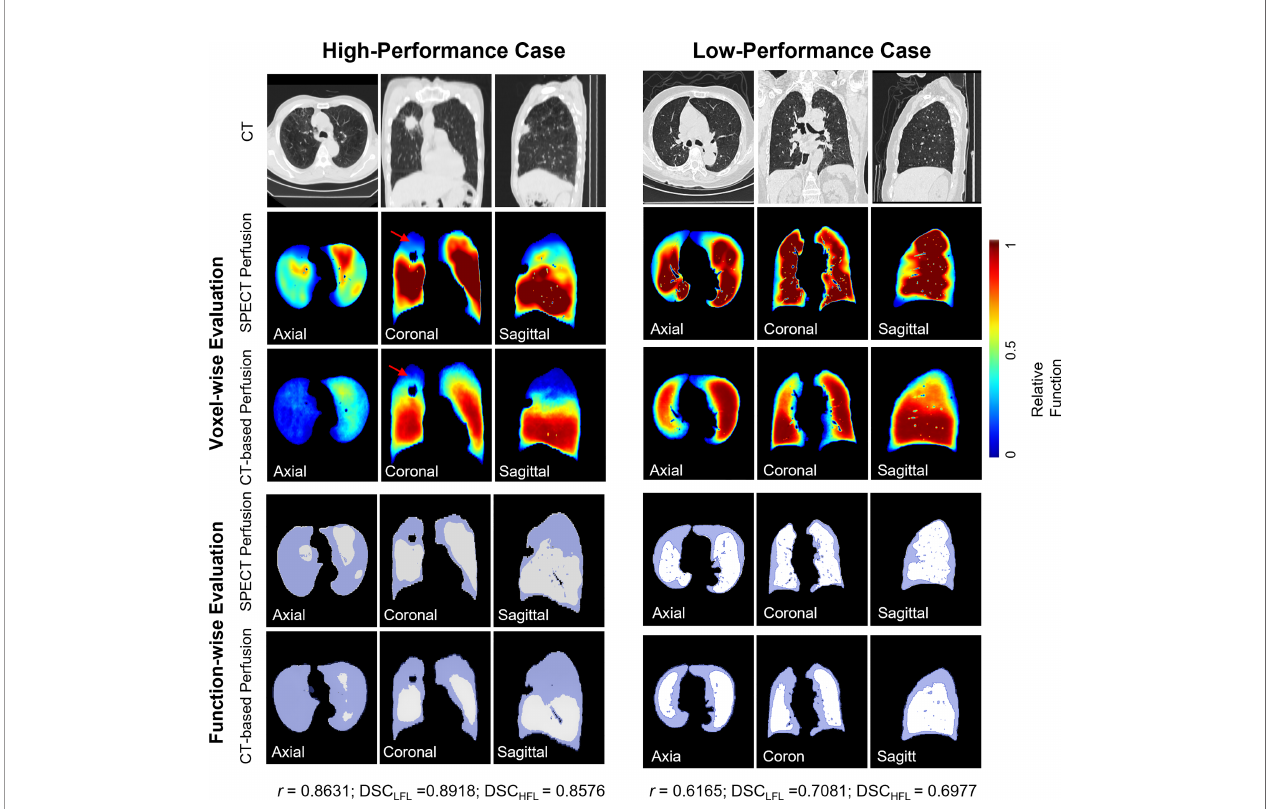
FIGURE 3 | Comparison of SPECT perfusion images and CT-based perfusion images in terms of voxel-wise correlation and function-wise similarity for two representative lung cancer cases. Each case is presented in axial, coronal, and sagittal views. In the voxel-wise evaluation, the red arrow indicates the main low functional regions. In function-wise evaluation, the blue contour indicates the low functional volume for treatment planning, while the white contour indicates the high functional volume. It shows results of voxel-wise correlation and function-wise similarity in representative lung cancer patients. For the high-performance case in the testing group, the low functional region on the right upper region was successfully predicted on the CT-based perfusion. For the low-performance case in the testing group, no apparent low functional region was observed on the synthesized and ground-truth images. For both cases, CT-based perfusion images showed similar low-functional/high-functional regions to their respective SPECT perfusion